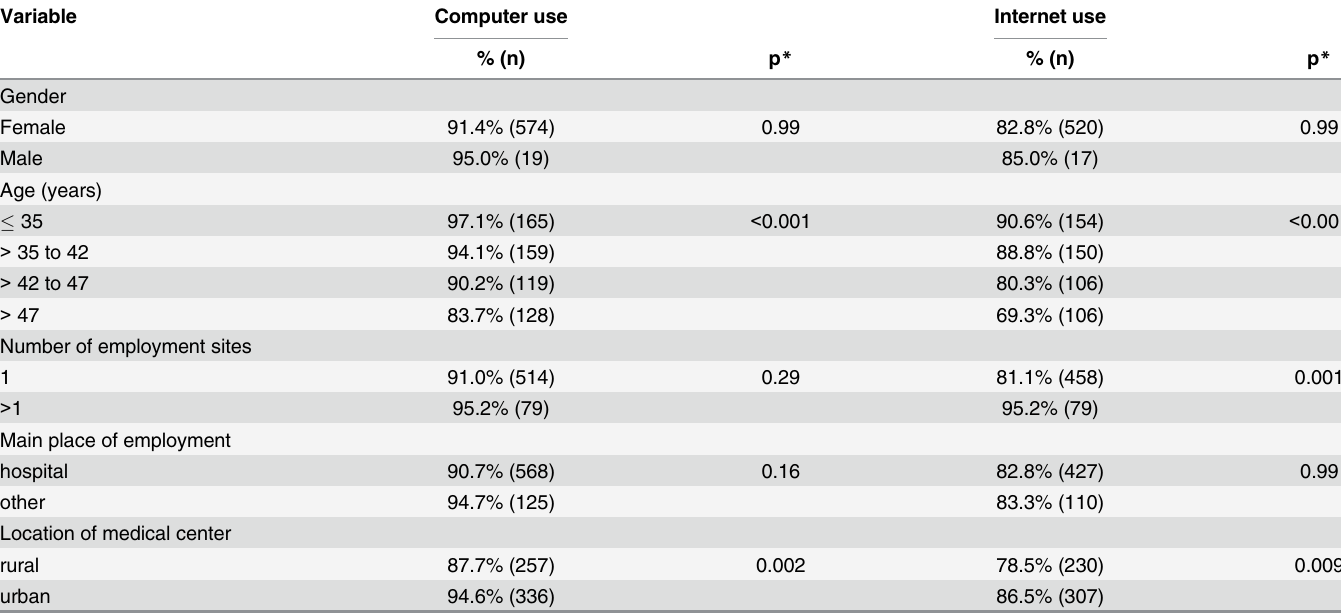
Table 2. Factors influencing computer and Internet usage.